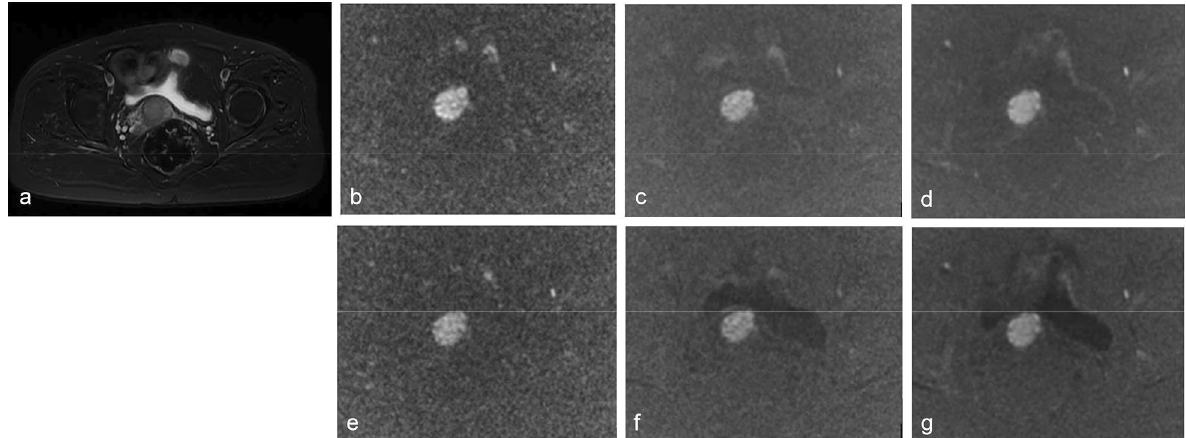
Fig. 5 A 65-year-old woman with stage IIB cervical cancer. Illustration of the significant lesions on T2-weighted image ( a) as well as 13b-protocol and 5b-protocol rFOV-DWI with b value of 0 and 1200 or 1500 s/mm 2 , including rFOV-sDWI 13b 13b = 1500 ( f ), rFOV-syDWI 5b = 1200 ( d ), and rFOV-syDWI 5b = 1500 s/mm